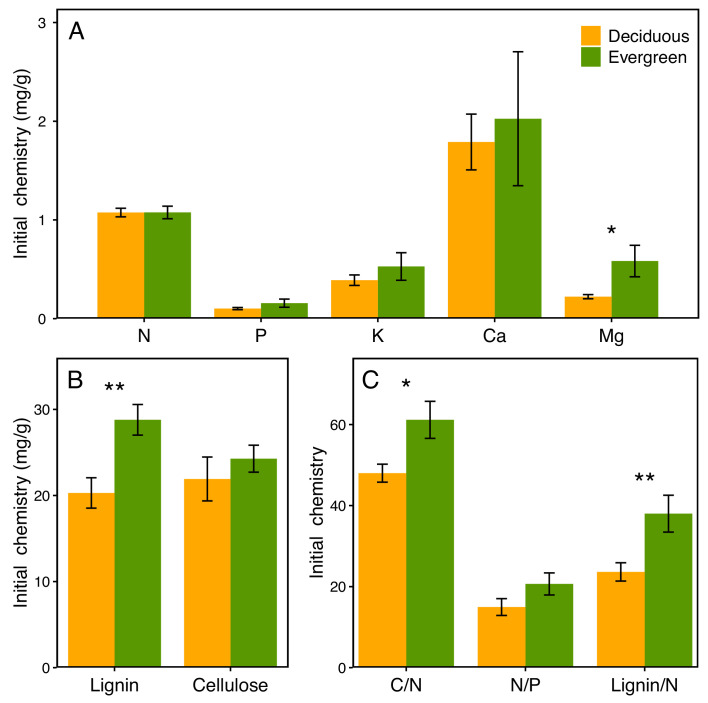
Initial quality of leaf litter from deciduous and evergreen species included in the meta-analysis.Initial quality of leaf litter from deciduous (n = 82) and evergreen (n = 81) species included in the meta-analysis. The specific number of deciduous or evergreen species varied among the different litter quality parameters, because not all parameters were measured for all species.